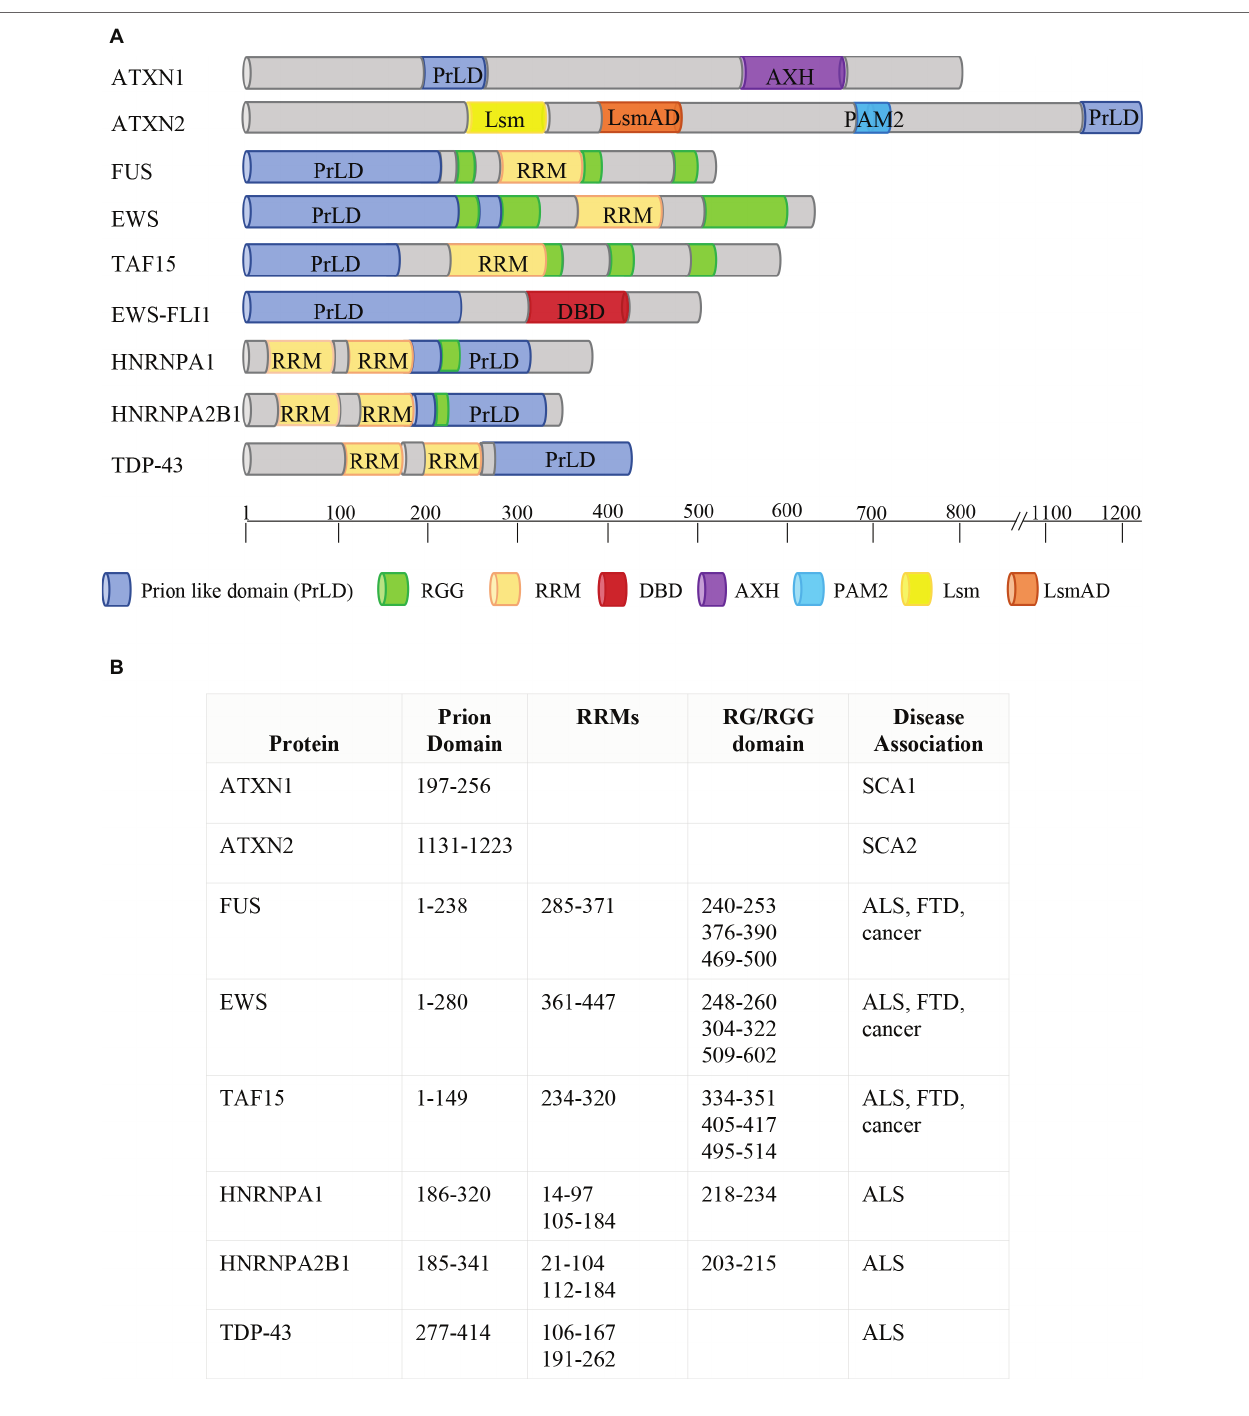
FIGURE 2 | Phase Separation by RBPs. (A) Schematic representation of protein domains of RBPs involved in FTD, ALS, and cancer. ATXN1 and ATXN2 contain two predicted prion-like domains (ATXN1: aa197–256; ATXN2: aa1131–1,223; March et al., 2016). The FET proteins FUS, EWS, and TAF15 combine two types of low-complexity domain (LCD): prion-like domains (PrLDs) and RGG-rich domains. The two types of LCDs cooperate to drive the dynamic phase separation. FET proteins are frequently translocated in human cancers, with the resulting fusion proteins (e.g. EWS-FLI1) lacking either significant parts of the RGG-rich LCD or the RNA recognition motif (RRM) but containing the DNA-binding domain (DBD) of an ETS transcription factor (e.g. FLI1). HNRNPA1 and HNRNPA2 combine two RRM motifs with a PrLD, together with an RG domain. TDP43 contains two RRM motifs and a PrLD. Protein domains are indicated in different colors (see legend). AXH = Ataxin-1 and HMG-box protein domain; Lsm = Like RNA splicing domain Sm1 and Sm2; LsmAD = Like-Sm-associated domain; PAM2 = poly (A)-binding protein interacting motif. The location of each protein domain and the association with human pathologies are indicated in (B) . SCA1 = spinocerebellar ataxia type 1; SCA2 = spinocerebellar ataxia type 2; ALS = Amyotrophic Lateral Sclerosis; FTD = Frontotemporal